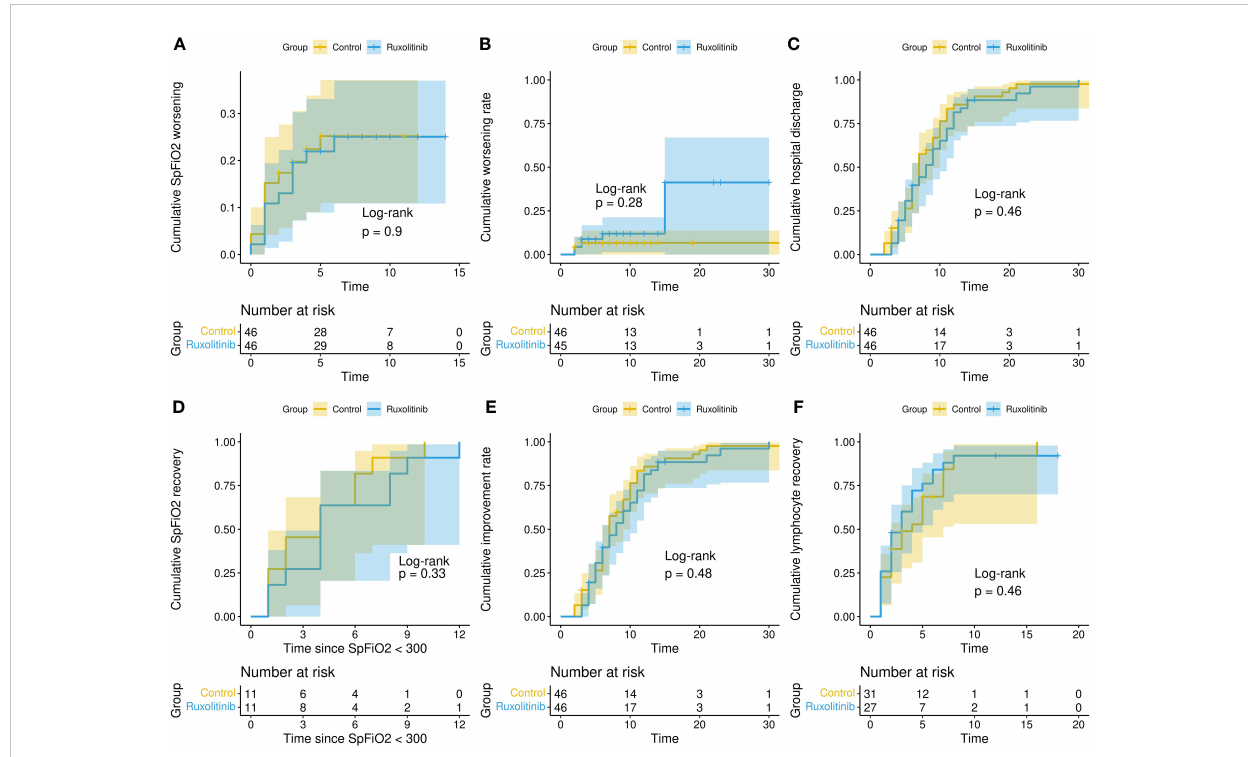
FIGURE 2 Clinical outcomes. Cumulative distribution for different clinical outcomes (time to event in days): SpFiO2 worsening [< 300] (A) ; clinical worsening [OSCI > 5] (B) , hospital discharge (C) ; SpFiO2 recovery (D) ; clinical improvement [reduction of two points on the OSCI scale] (E) and recovery from lymphopenia (F)